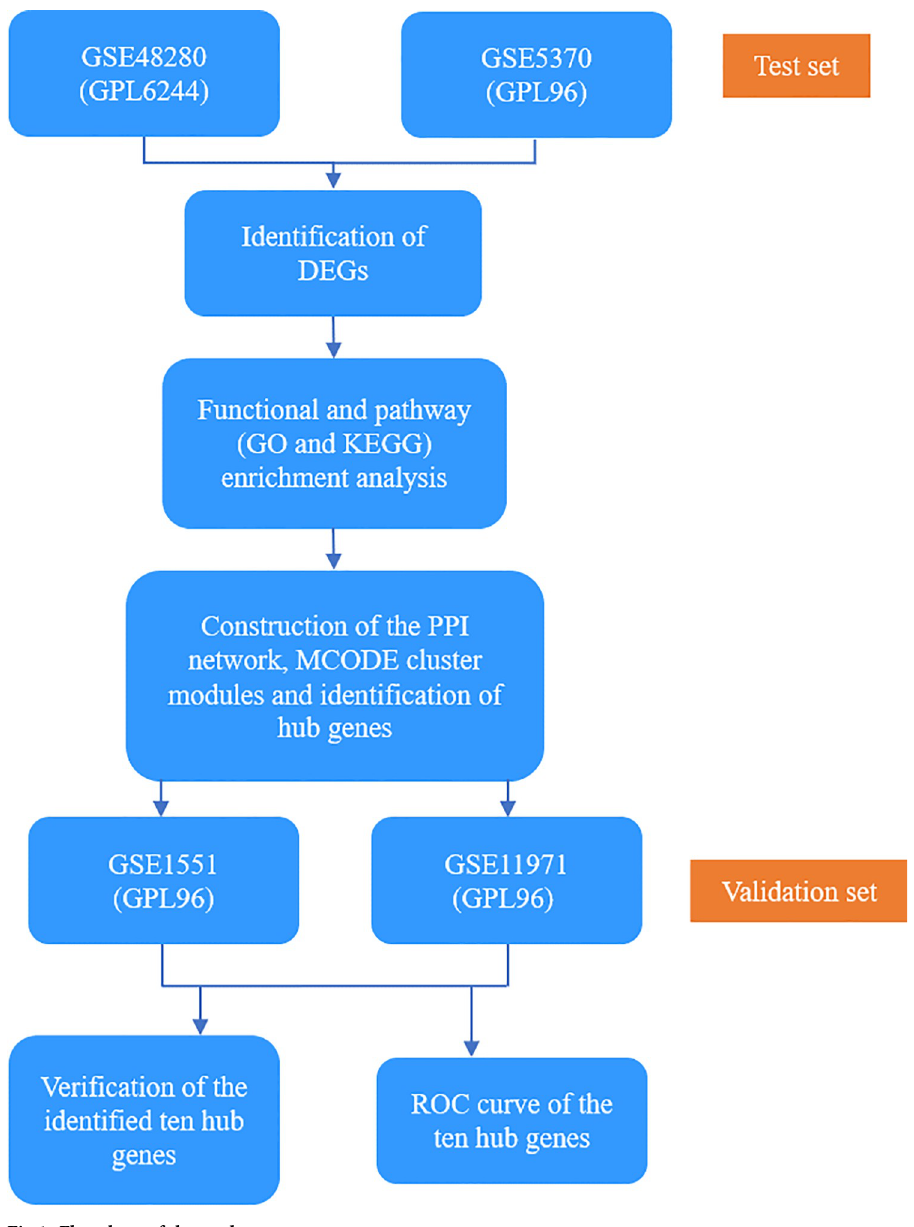
Fig 1. Flowchart of the